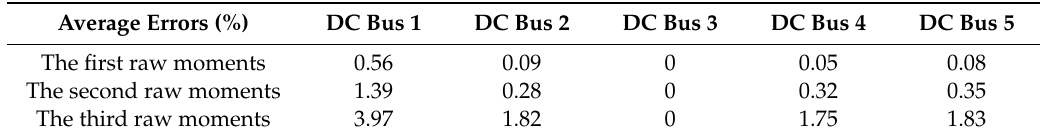
Table 9. The average errors of the first to third raw moments of DC bus voltages with di ff erent correlation coe ffi cients.